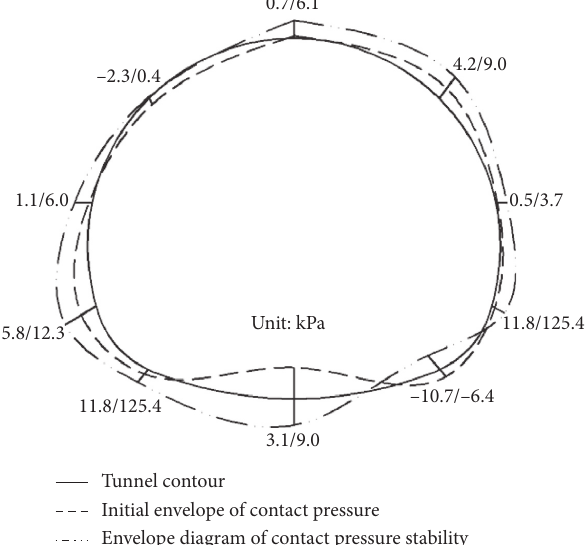
Figure 17: DK-190+617 mileage concrete internal force envelope diagram of Zaosheng Tunnel.